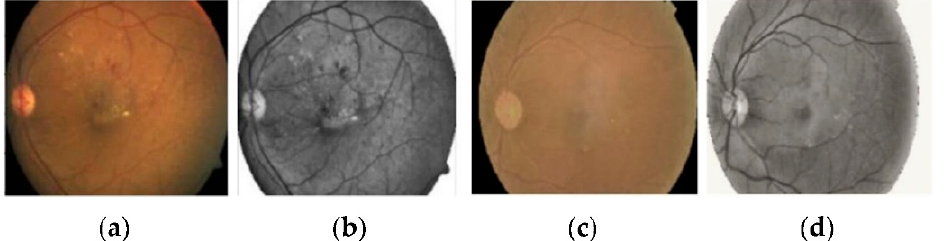
Figure 4. The preprocessed retinal images after applying contrast limited adaptive histogram equalization to adjust contrast in images. ( a , c ) Original retinal fundus images, ( b , d ) preprocessed images.